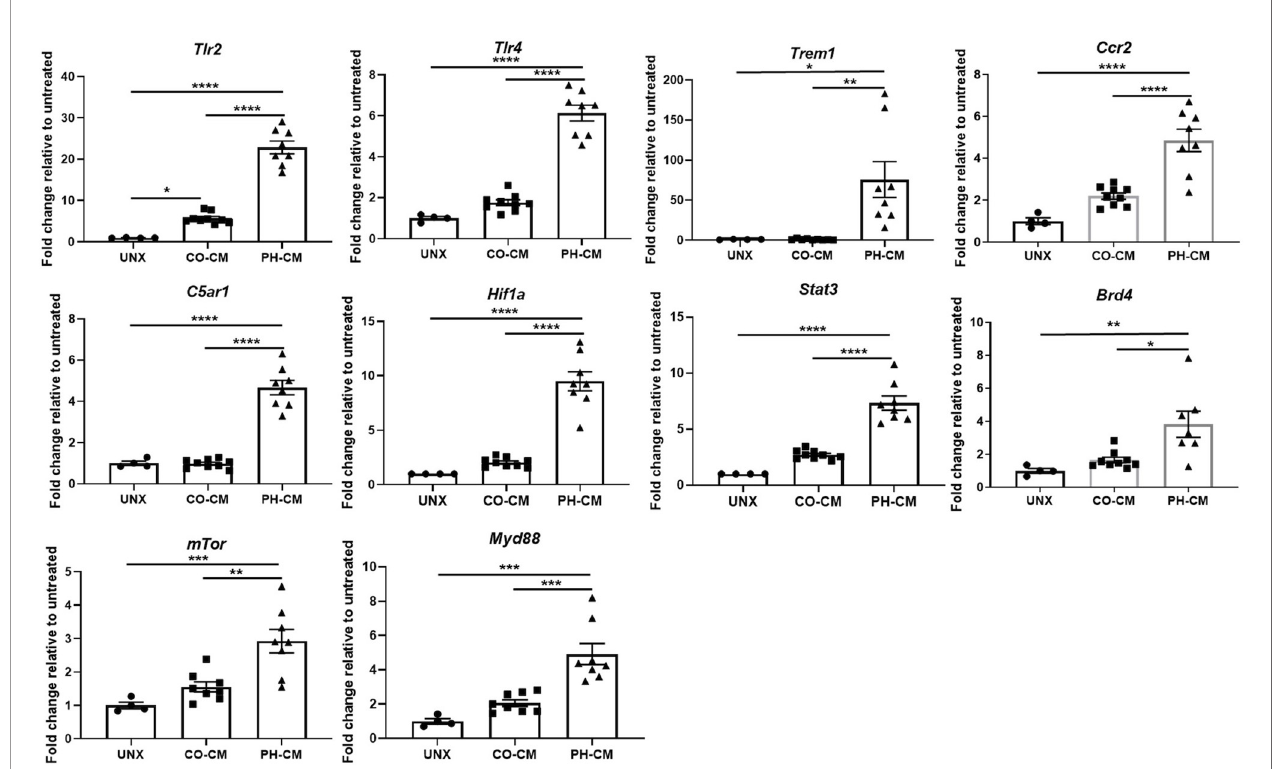
FIGURE 2 | qPCR con fi rmed gene expression of key upstream regulators in CO-CM and PH-CM stimulated BMDMs. In order to con fi rm the upstream regulators predicted by IPA in Figure 1D . mRNA were collected from untreated (UNX), CO-CM and PH-CM treated BMDMs and gene expression was examined by qPCR analysis. Data is represented by fold change relative to untreated BMDM, and displayed as mean ± sem. * p < 0.05, ** p < 0.01, *** p < 0.001, **** p <